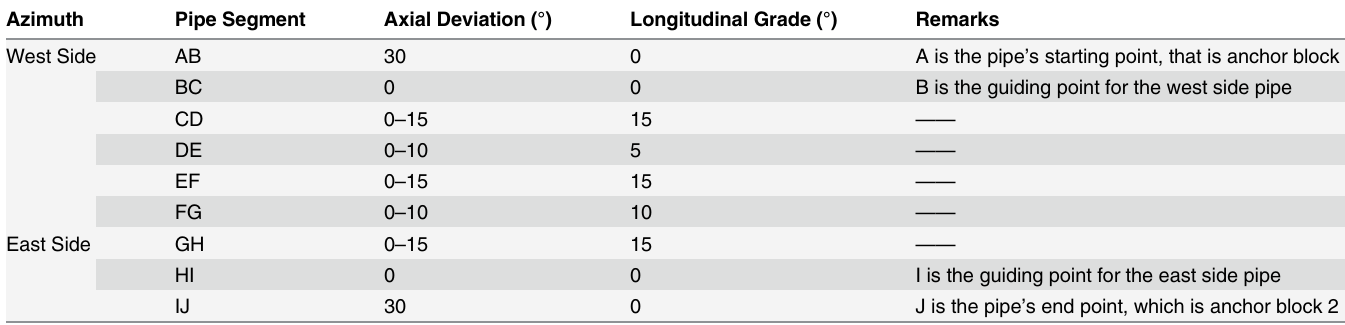
Table 2. Special location parameters of